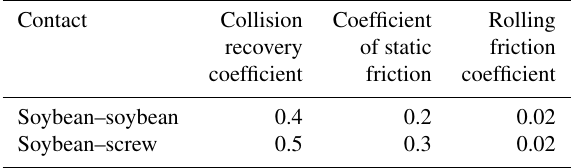
Table 3. Contact parameters. Contact